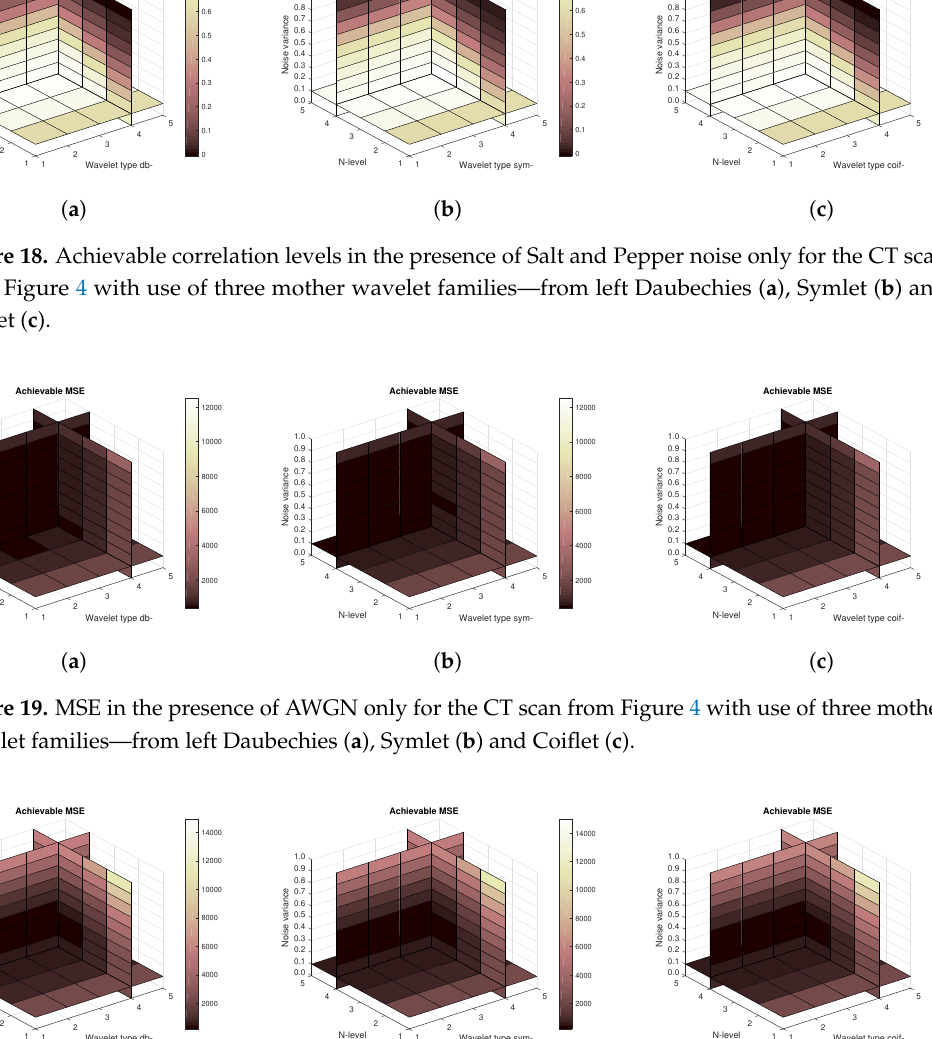
50.20.30.4 0.00.1